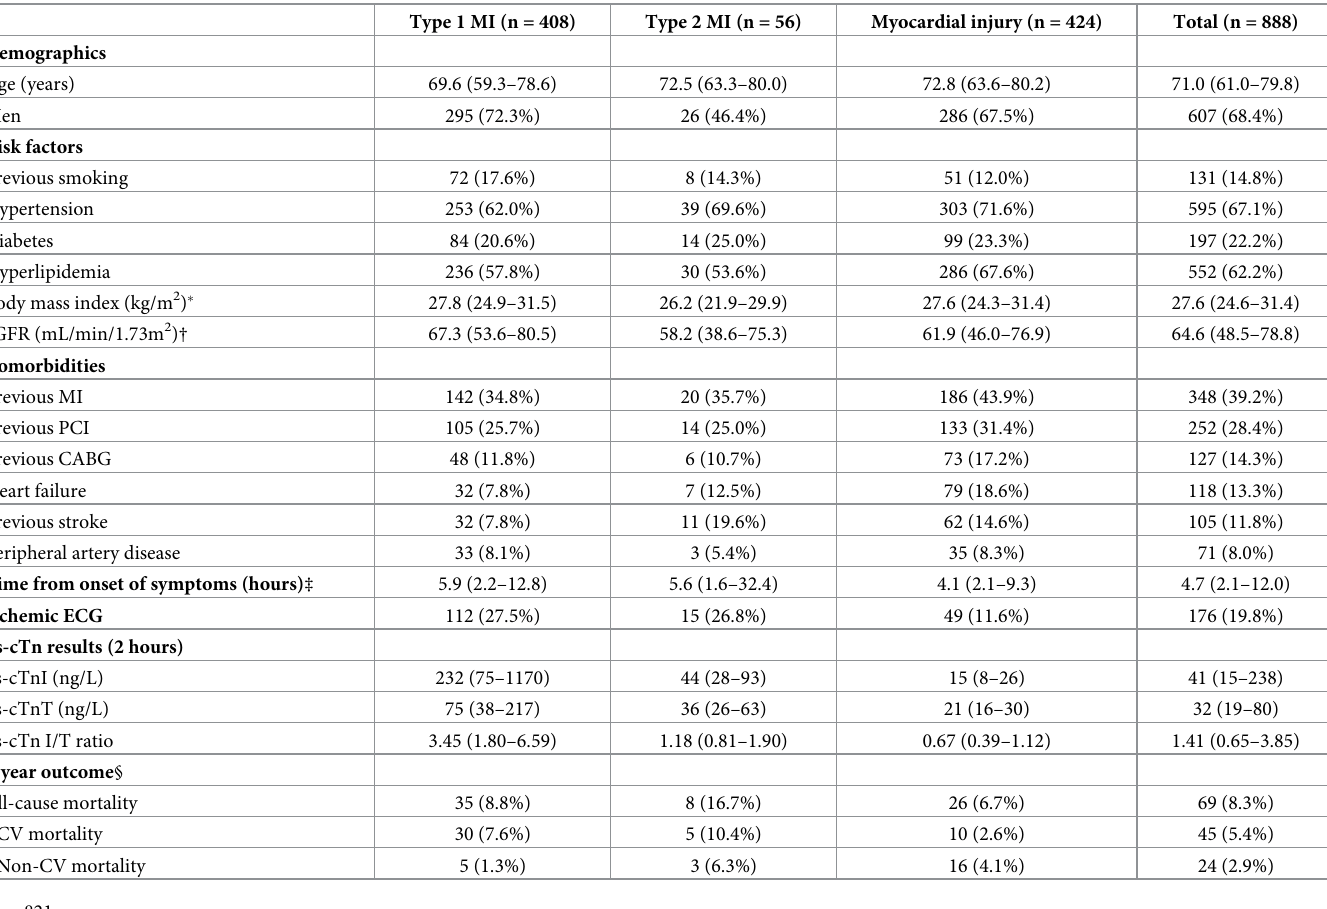
Table 1. Clinical characteristics and 1-year